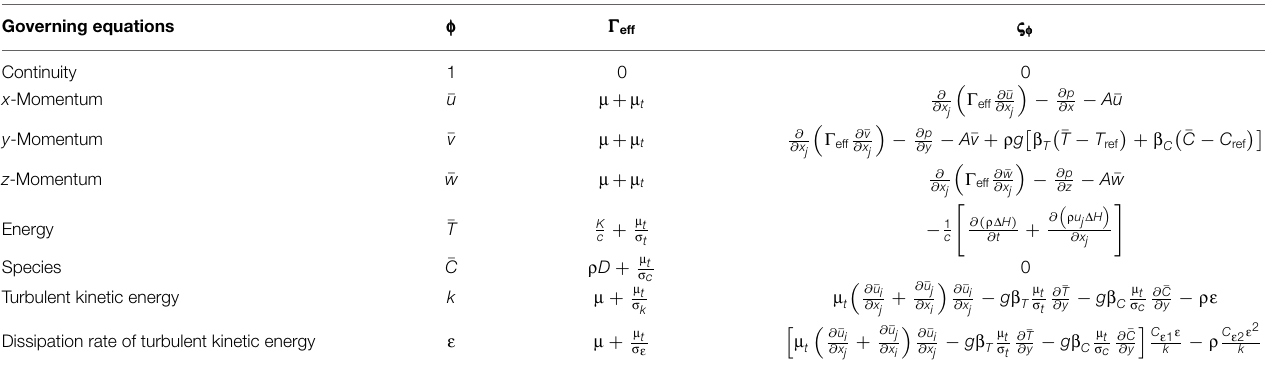
TABLE 1 | Diffusion coefficients and source terms for various conservation equations . Governing